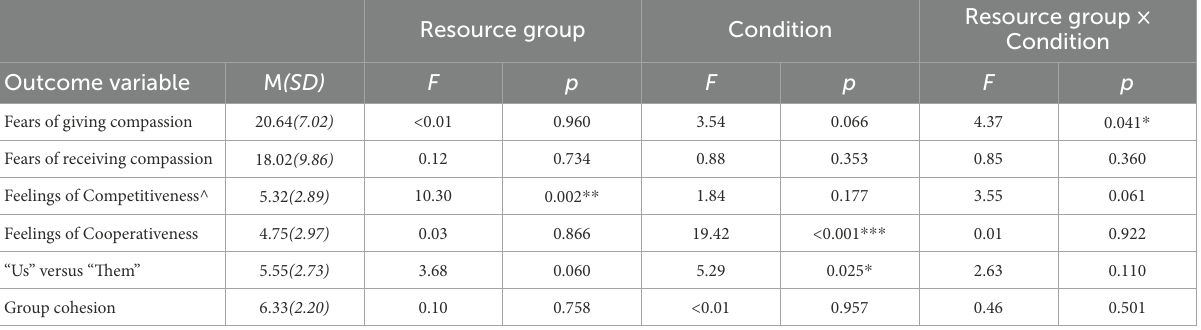
TABLE 5 Linear mixed models for Study 3 exploring the effect of condition and resource group on fears of compassion, as well as group dynamics and cohesion.